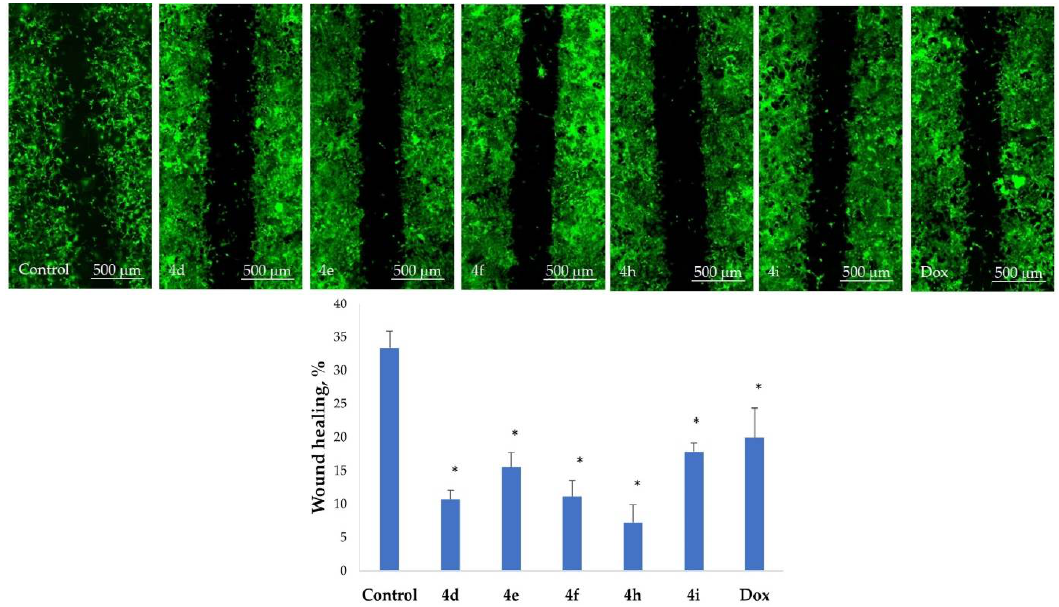
Figure 12. Microscopic images of the CT26 cells wound area in the scratch assay and wound area (%) in the scratch assay after 24 h incubation post azaspiro[bicycle[3.1.0]hexane-2,5′-pyrimidines] 4 treatment. Bars indicate SD; * p value < 0.05.